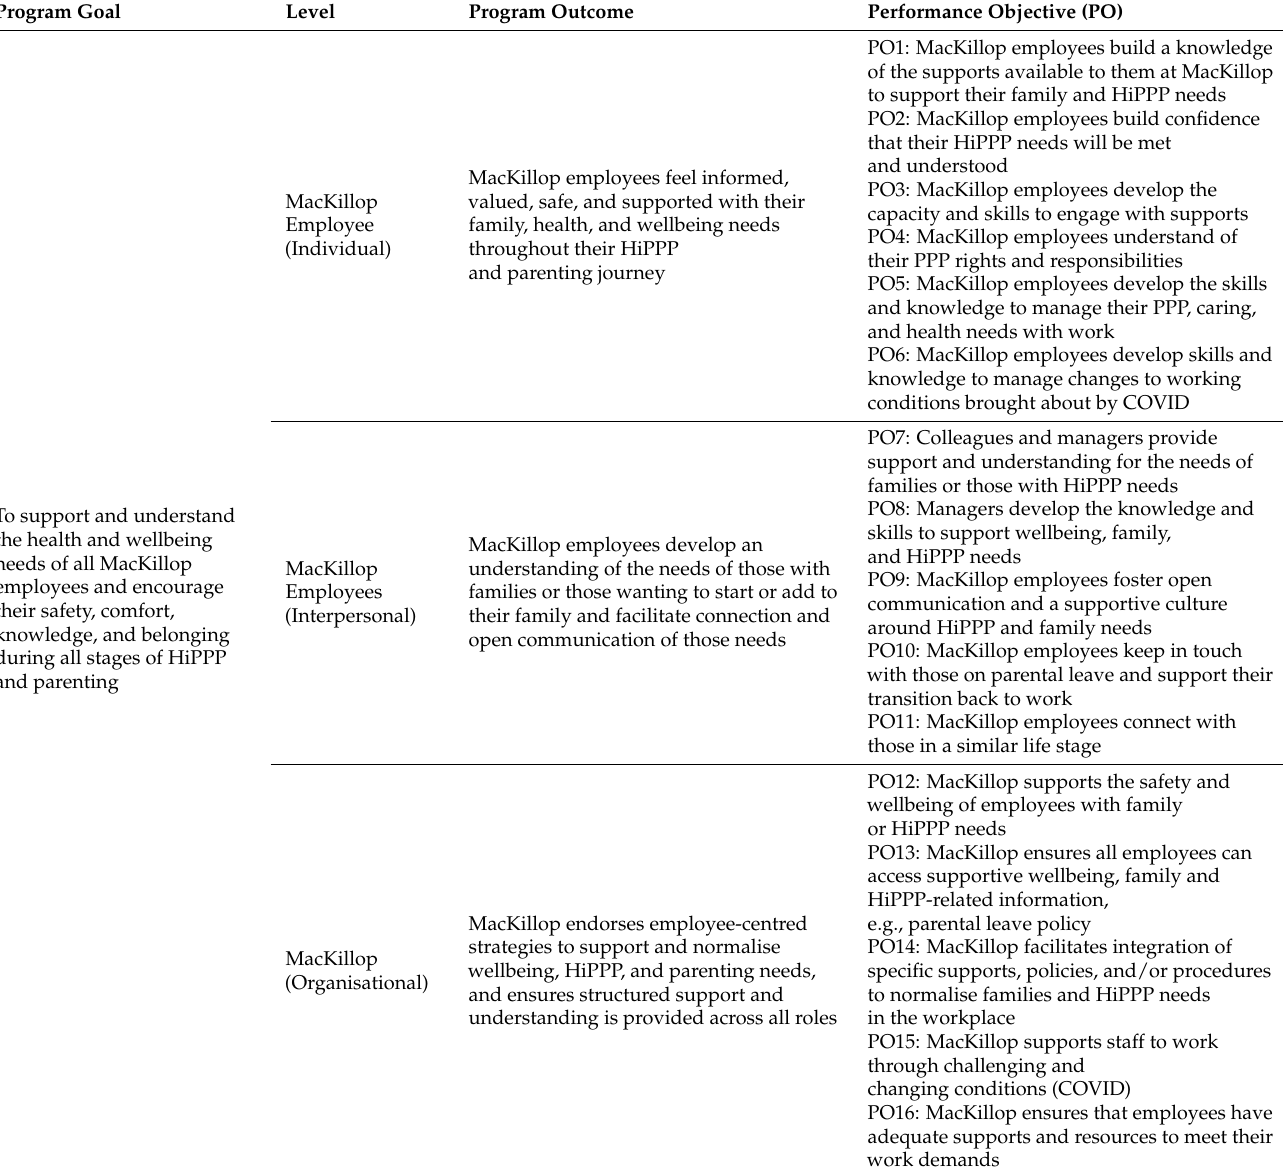
Table 5. Program Outcomes and Performance Objectives for the HiPPP Portal According to Socio- Ecological Level.